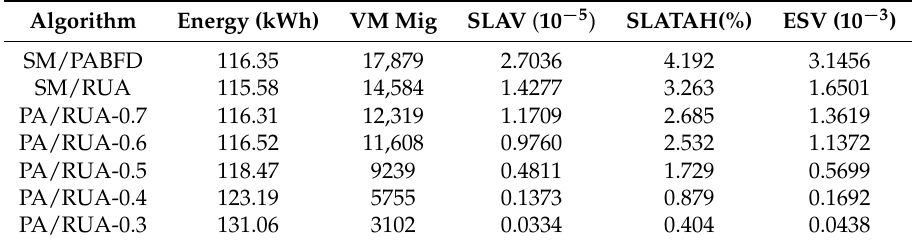
Table 2. Experiment results. SM, simple method; PABFD, power-aware best fit decreasing; RUA, remaining